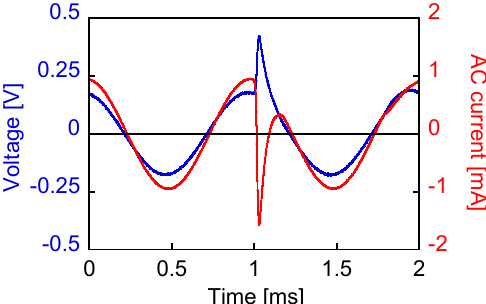
Figure 11. Voltage and current waves when an AC current of 1 mA amplitude is applied. A large Barkhausen jump is caused by the magnetic field of a slow-moving magnet having dimensions of 3 × 3 × 5 mm 3 .